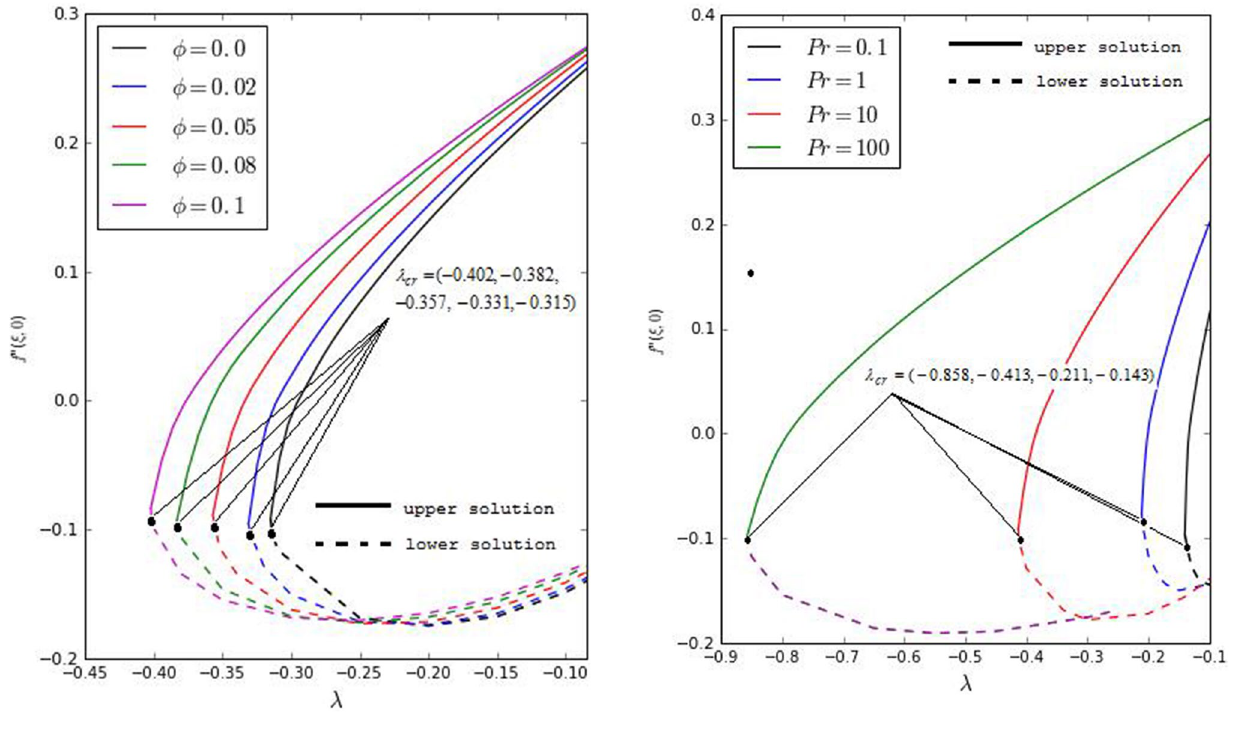
Fig. 6 Profiles for f �� ( 𝜉 ,0 ) for Pr = 0.1,1,10 and 100 for buoyancy opposing flow ( 𝜆 < 0 ) for fixed 𝜙 = 0.05